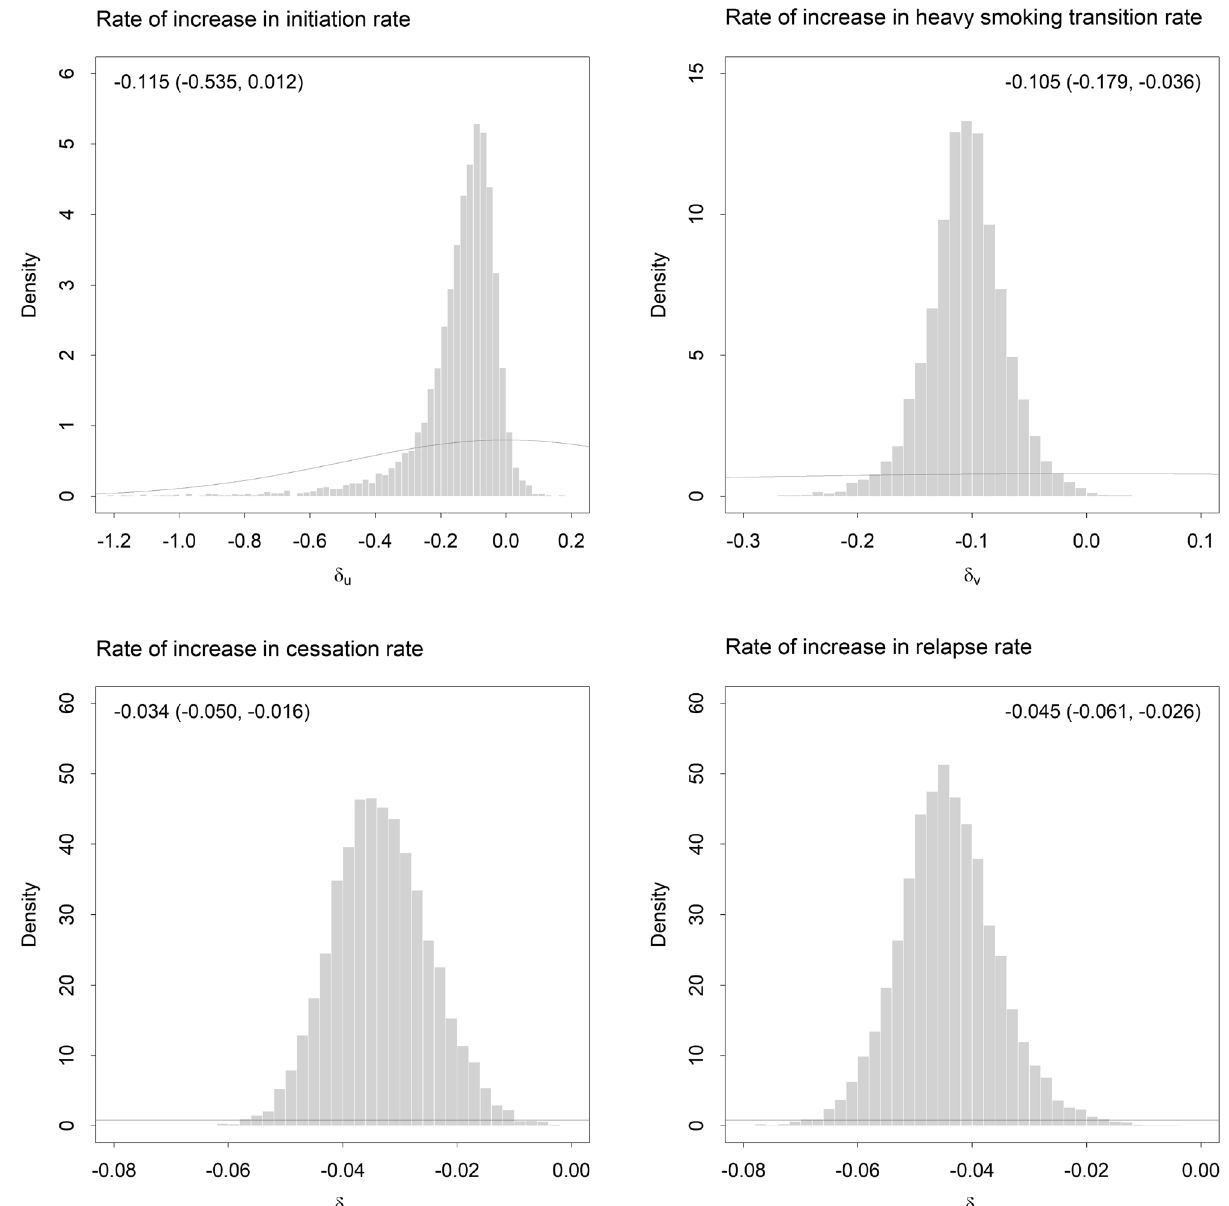
Figure 3. Marginal posterior distributions inferred for fractional rates of increase in per capita rates of smoking behaviour change in the Australian smoking population over the period 2001 ‒ 2016. The histograms were generated from 8,000 parameter vectors ( θ ) sampled from the posterior distribution in the Markov chain Monte Carlo (MCMC) analysis. Median estimates and 95% posterior intervals are shown in the top left or right corner. Prior distributions are plotted as smooth proportion of heavily dependent smokers in the smoking population (from 52.1% in 2001 to 36.9% in 2016). These results are largely consistent with the two recent analyses of smoking behaviour trends in the United States, Europe, and New Zealand described in the Introduction 7,8 , and suggest that the potential for hardening in smoking populations subjected to a range of WHO FCTC-prescribed tobacco control measures is minimal. Policy interventions that are effective in limiting cigarette consumption and promoting cessation (e.g., tobacco tax increases, smoke-free environment policies, antismoking mass media campaigns) 19–21 in particular are expected to lead to a decline in the proportion of current smokers who are heavily dependent, while also reducing smok- ing prevalence (see Fig. 2). The decline in the total per capita cessation rate among Australian smokers evident from Fig. 4 suggests that the average ability or motivation of smokers to quit is at least partially independent of changes in the proportion of smokers who are heavily dependent. Although the reasons for this decline are unclear, one possible contrib- uting factor is a decrease in perceived self-efficacy attributable to the shifting demographic composition of the